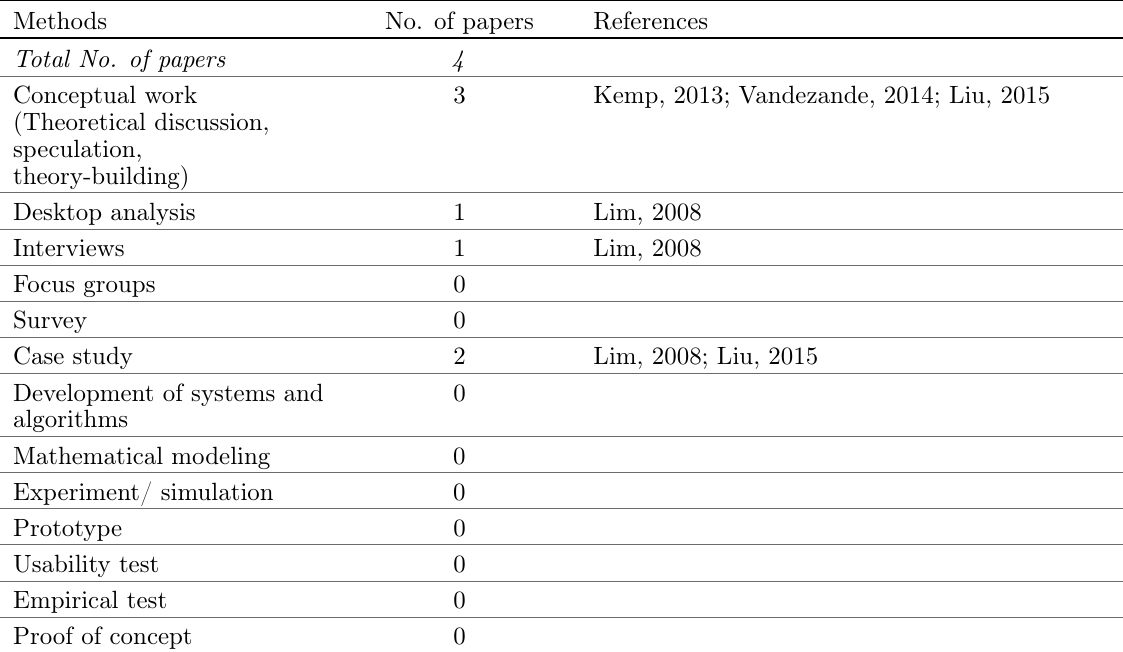
Table B.4 . Research methods used in studies on mobile payments’ law and regulation as-